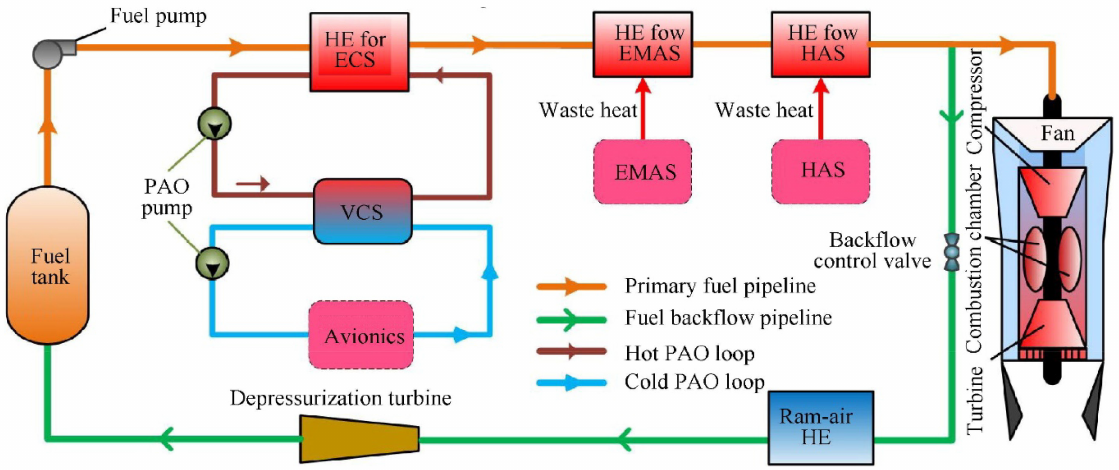
Figure 7. Layout of a single-phase MPFL system in aircraft